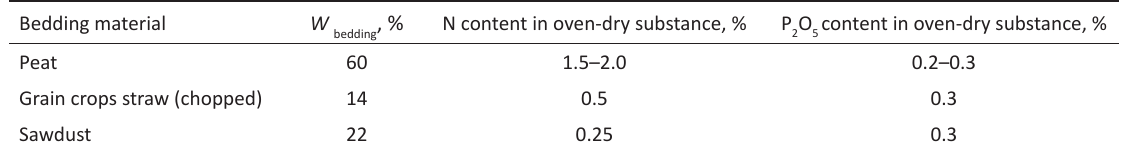
Table 3. Moisture and nutrients content of applied bedding material Bedding material